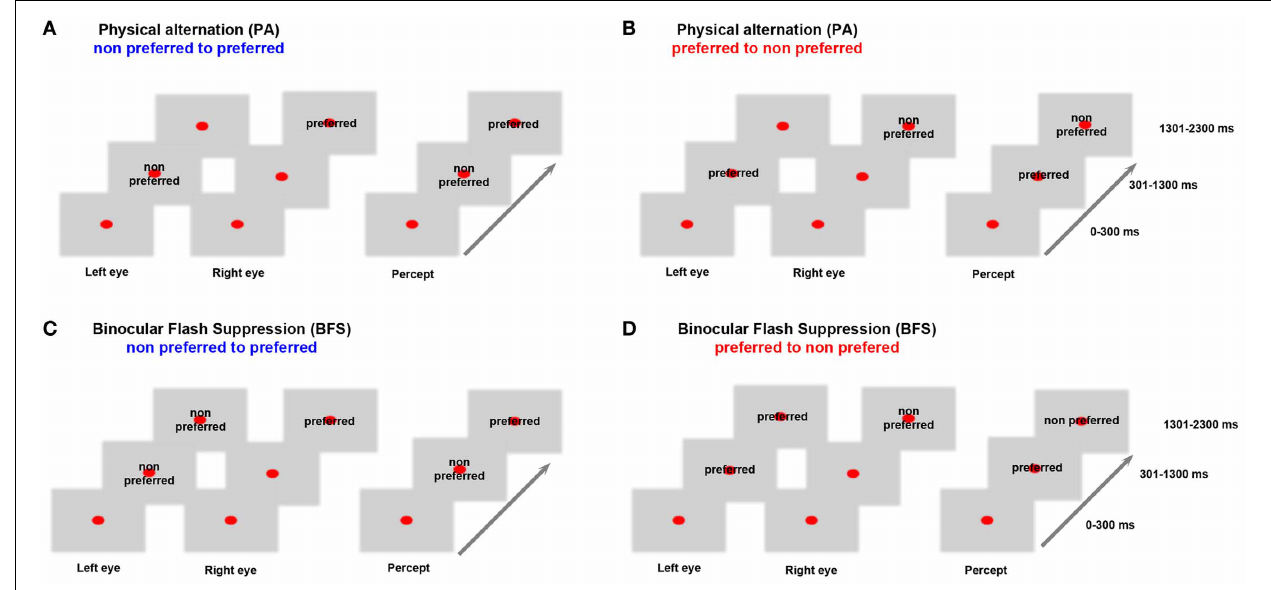
FIGURE 1 | Behavioral task. In (A) monocular stimulation with a non-preferred pattern is followed by stimulation of the contralateral eye with a preferred visual stimulus. In (B) the order of visual stimulation is reversed. These PA conditions allowed us to study neurophysiological responses during purely sensory stimulation without any underlying competition. In (C) the non-preferred stimulus is suppressed by the presentation of a preferred visual pattern while in (D) the preferred pattern is suppressed due to a flash